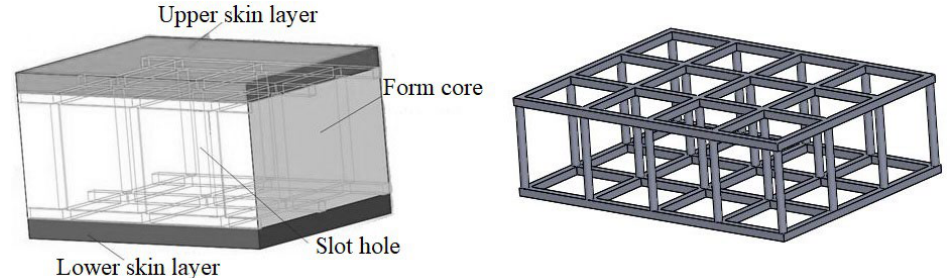
Figure 3. Diagram of the slot resin-reinforced sandwich composite and the resin stiffener structure.